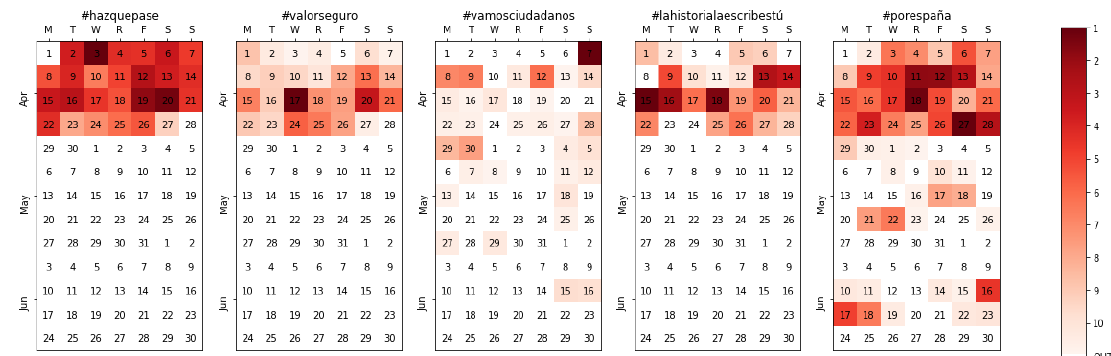
Figure 5. Calendar heatmap for the official slogan per party (top 5 parties) during the Spanish general elections campaign.